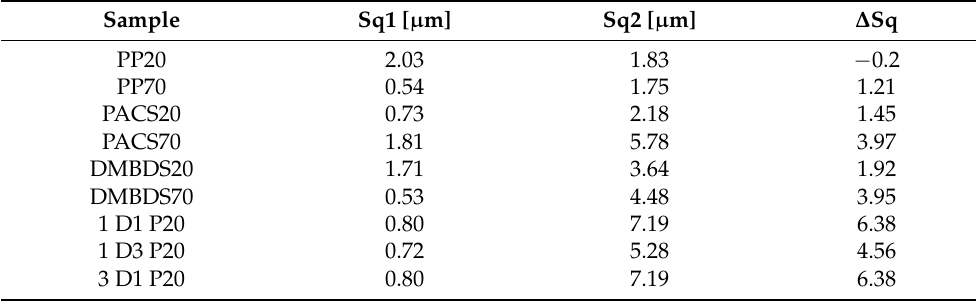
Table 5. The roughness parameter of the surface before the tests (Sq1) and as scratch formed during the friction test